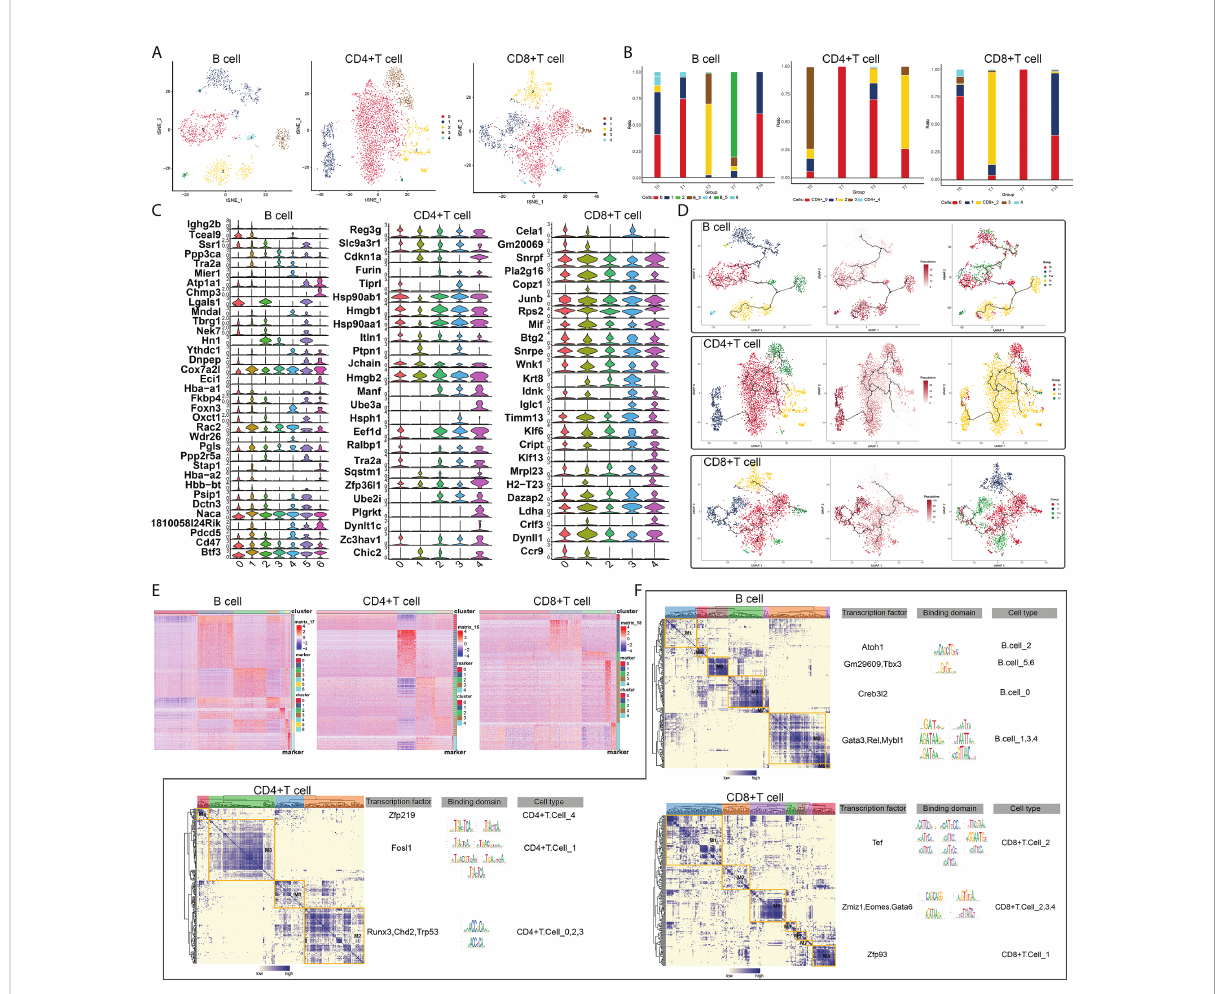
FIGURE 2 RT-induced changes in lymphocyte subpopulations in intestinal tissues. (A) Radiation reprograms the subset of lymphocyte immune cells. (B) Changes in abundance of lymphoid immune cell subsets. The colors of the different columns represent the changes in lymphocyte immune cells at different times after radiotherapy. (C) Radiation reprograms the expression of marker genes in a subset of lymphocyte immune cells. (D) Radiation reprogramming of immune cell subsets in the lymphatic system with increasing time after radiation exposure. (E) Expression of lymphoid immune cell genes in different subgroups. (F) Regulatory sub-modules of lymphoid immune cell subsets. B cell regulators were divided into seven modules; CD4+T cell regulators, four modules; and CD8+ T cell regulators, seven modules. The right side of the module diagram shows the regulator motif of lymphoid immune